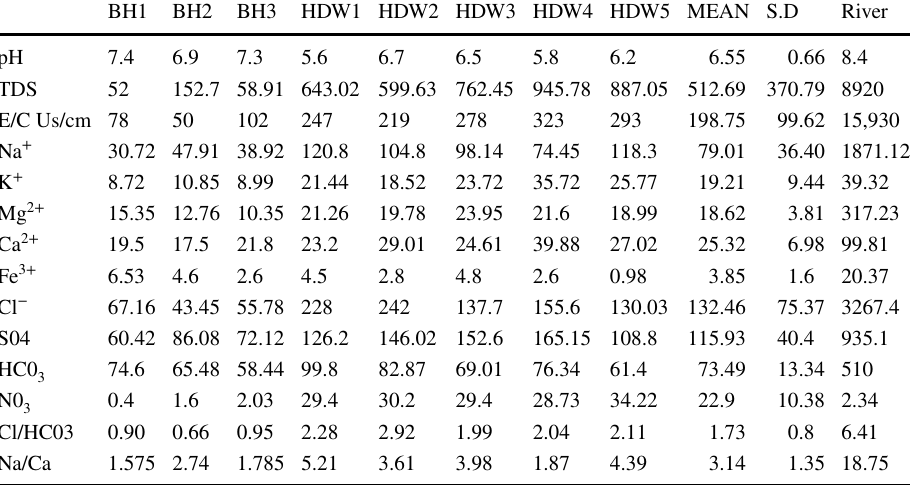
All parameters are in mg/l, except EC = (us/cm) and pH BH borehole, HDW